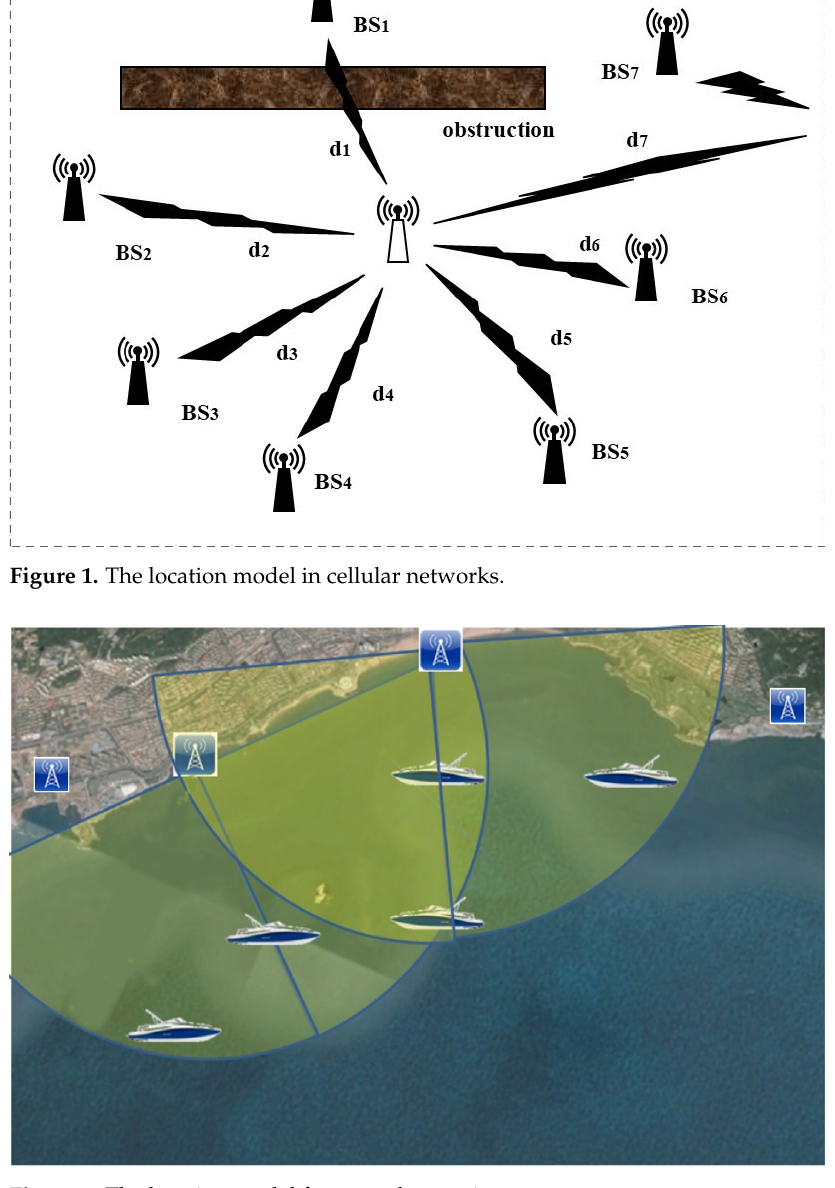
Figure 2. The location model for coastal